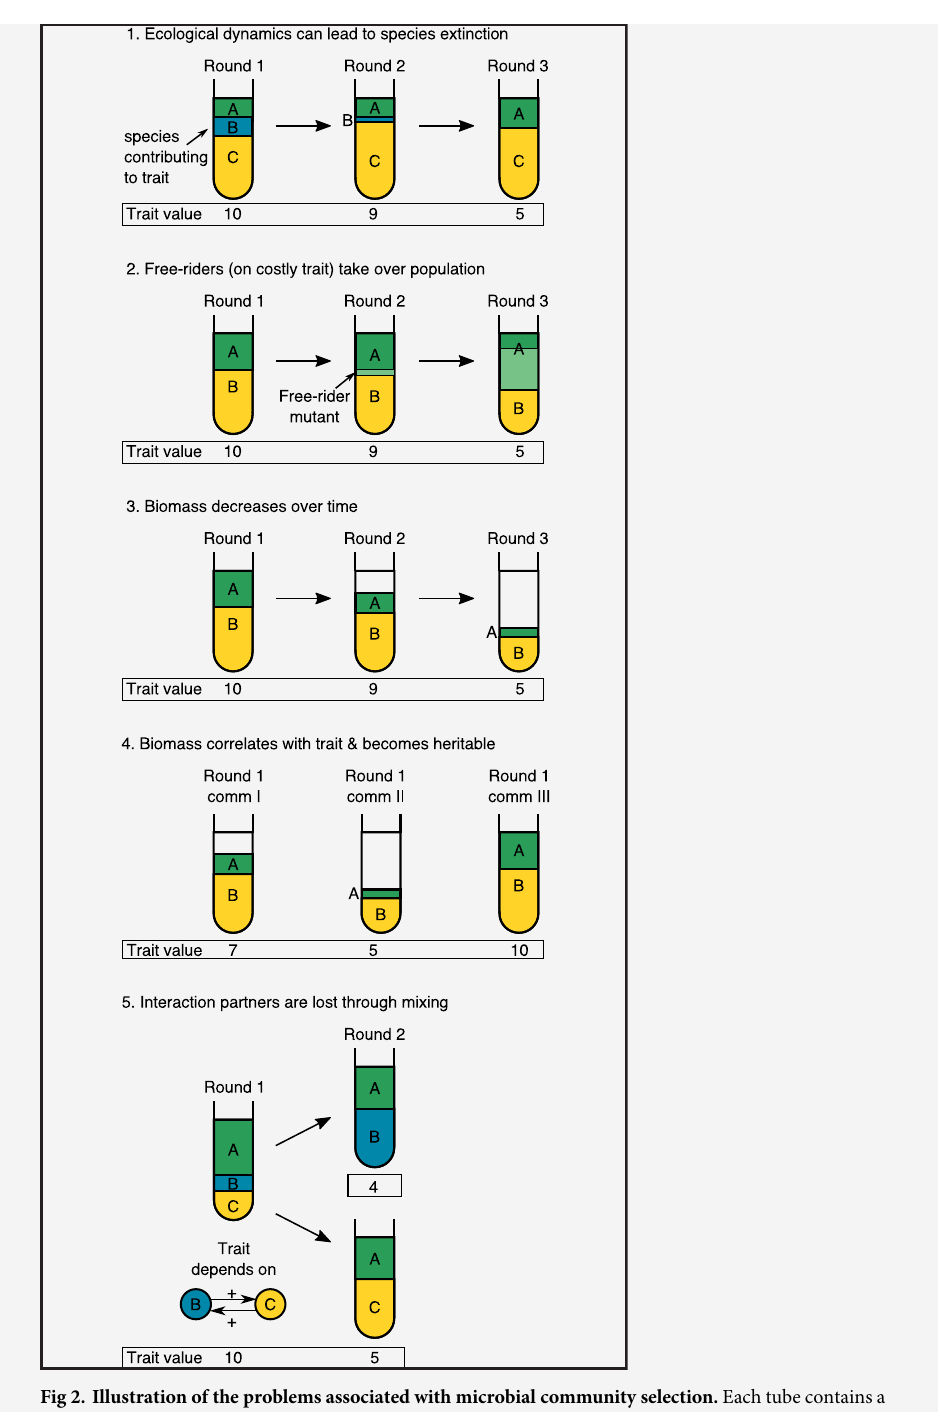
Fig 2. Illustration of the problems associated with microbial community selection. Each tube contains a community. Problems 1, 2, 3, and 5 show sequential rounds of selection, whereas problem 4 shows different communities within the same selection round. Letters represent species, and colors represent lineages (the two shades of green species A represent an ancestor and a mutant strain). Below each tube in a box is a trait value, which is used to select the best communities to be transmitted to the next selection round. Problems are described in Box